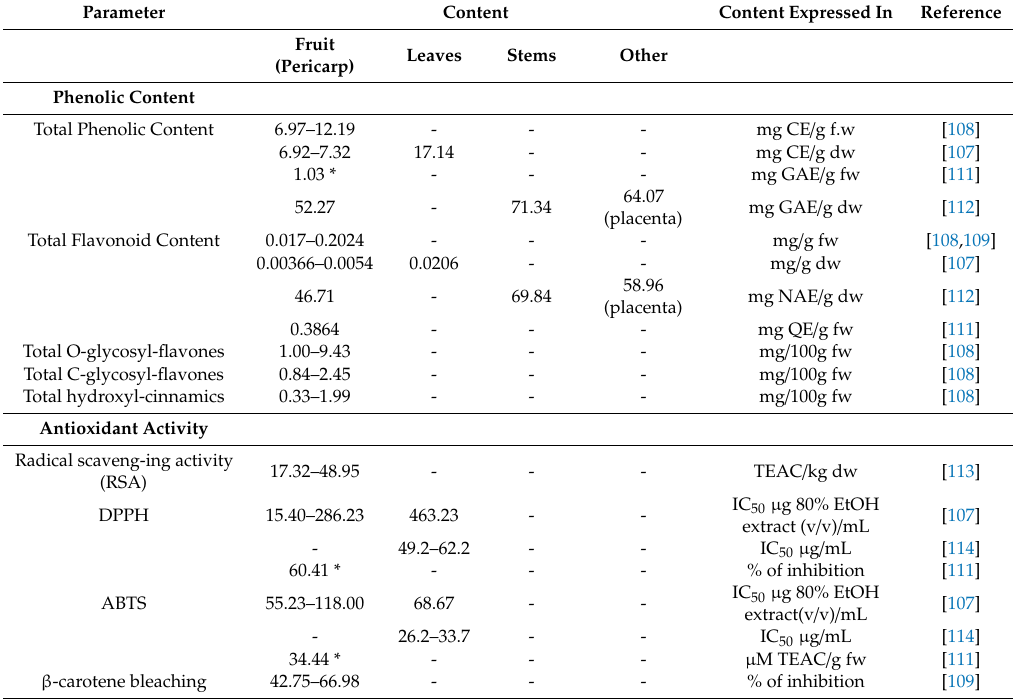
Table 1. Global antioxidant activity and phenolic content of Capsicum annuum L. in fruits, leaves and other